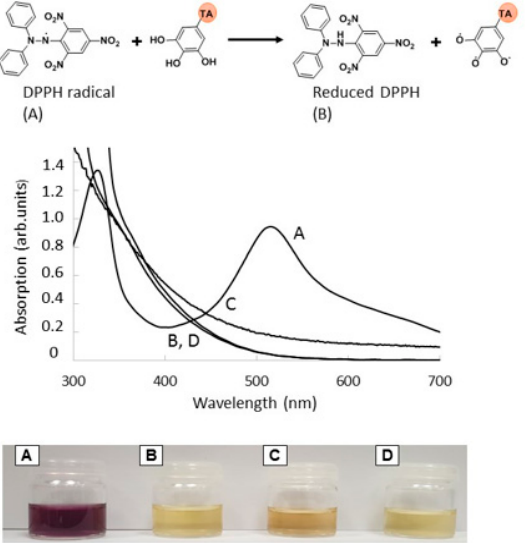
Figure 8. Absorption UV spectra in the presence of DPPH ( A ) and reduced DPPH after reaction with TA ( B ), TA-N(CH 3 ) 3+ ( C ), and PHOSO 3 − /TA-N(CH 3 ) 3+ ( D ).